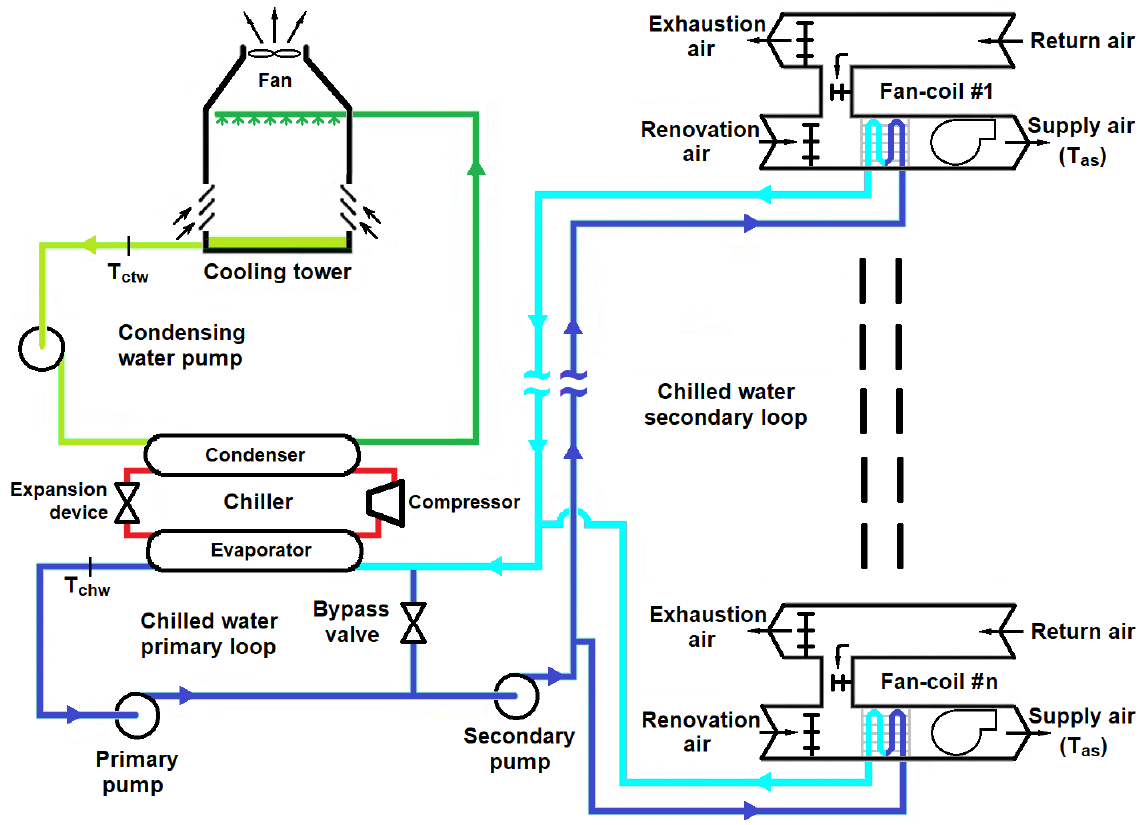
Figure 4. HVAC system diagram.